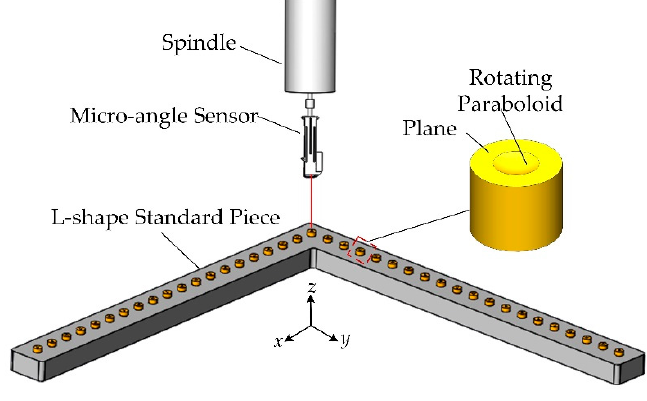
Figure 3. Composition of the measurement system.